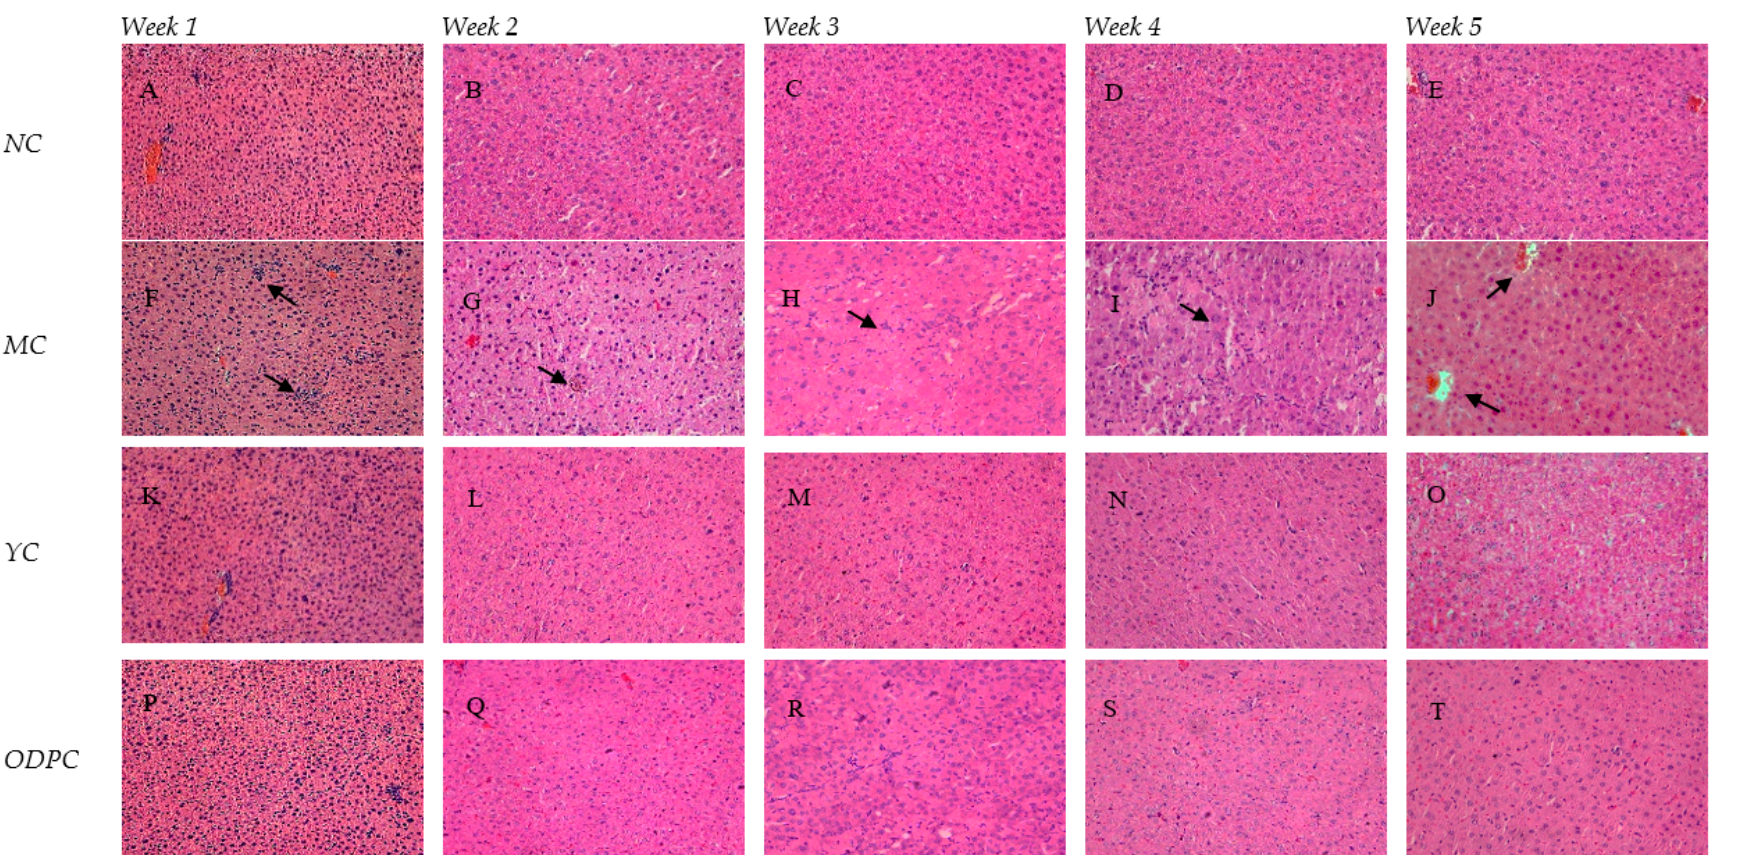
Figure 6. Representative H & E micrographs of time-dependent liver histopathology (400 × ): ( A – E ) NC group, ( F – J ) MC group, ( K – O ) YC group, and ( P – T ) ODPC group. NC: normal control group, MC: CdCl 2 -treated group, YC: positive-treated group, ODPC: ODP-treated group.